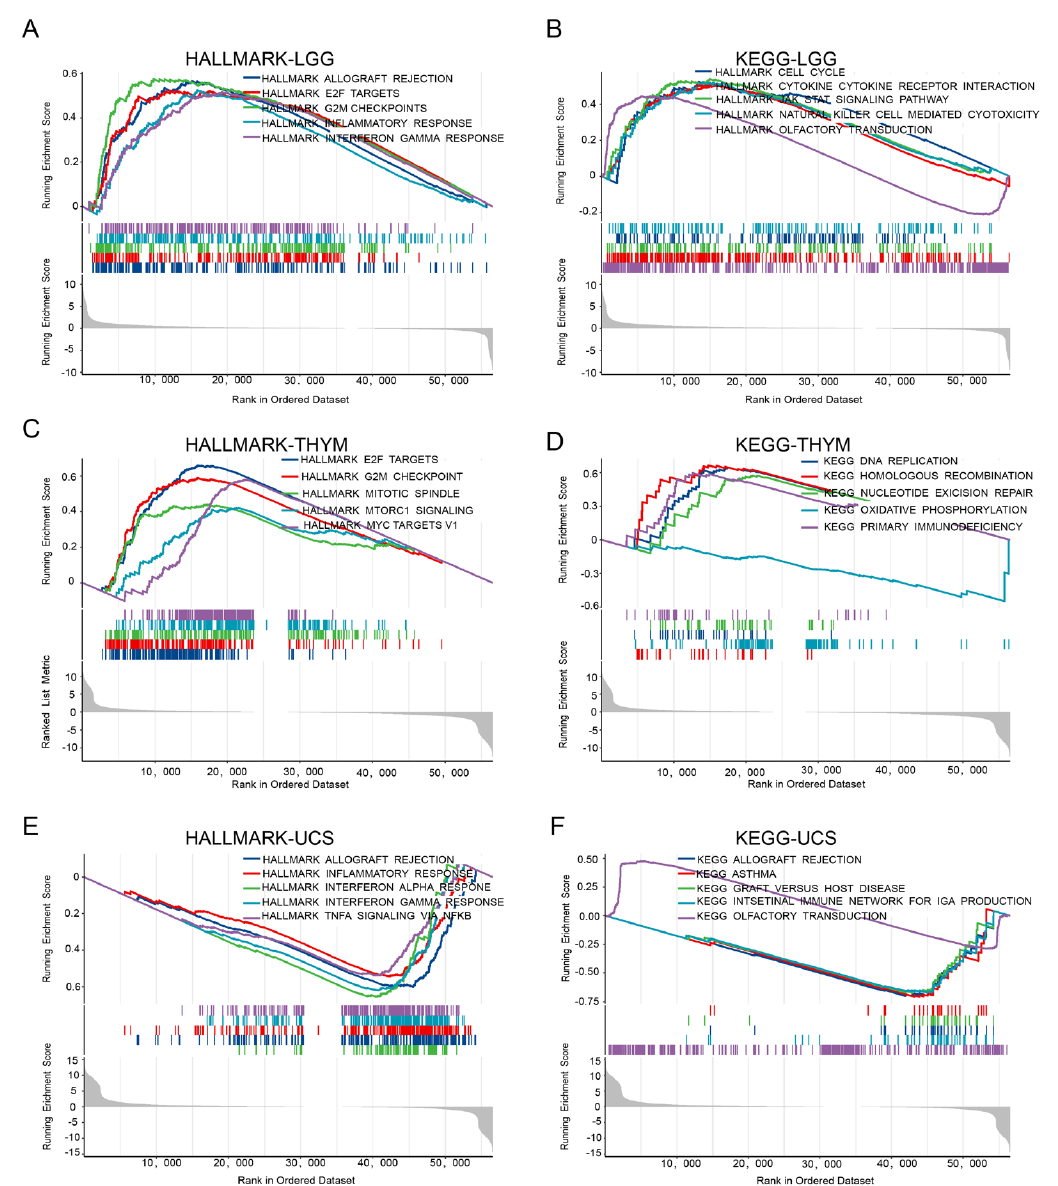
Figure 7. Gene set enrichment analysis (GSEA) regarding FAM72A for cancers. ( A – F ). Enrichment results of HALLMARK in LGG ( A ), THYM ( C ), and UCS ( E ). The enriched KEGG signaling pathways in LGG ( B ), THYM ( D ), and UCS ( F ).